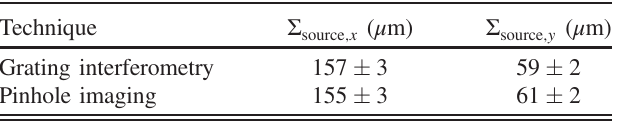
TABLE II. Projected source sizes extracted from grating interferometry and pinhole imaging measurements at 20 keV at the BMIT-BM beamline.